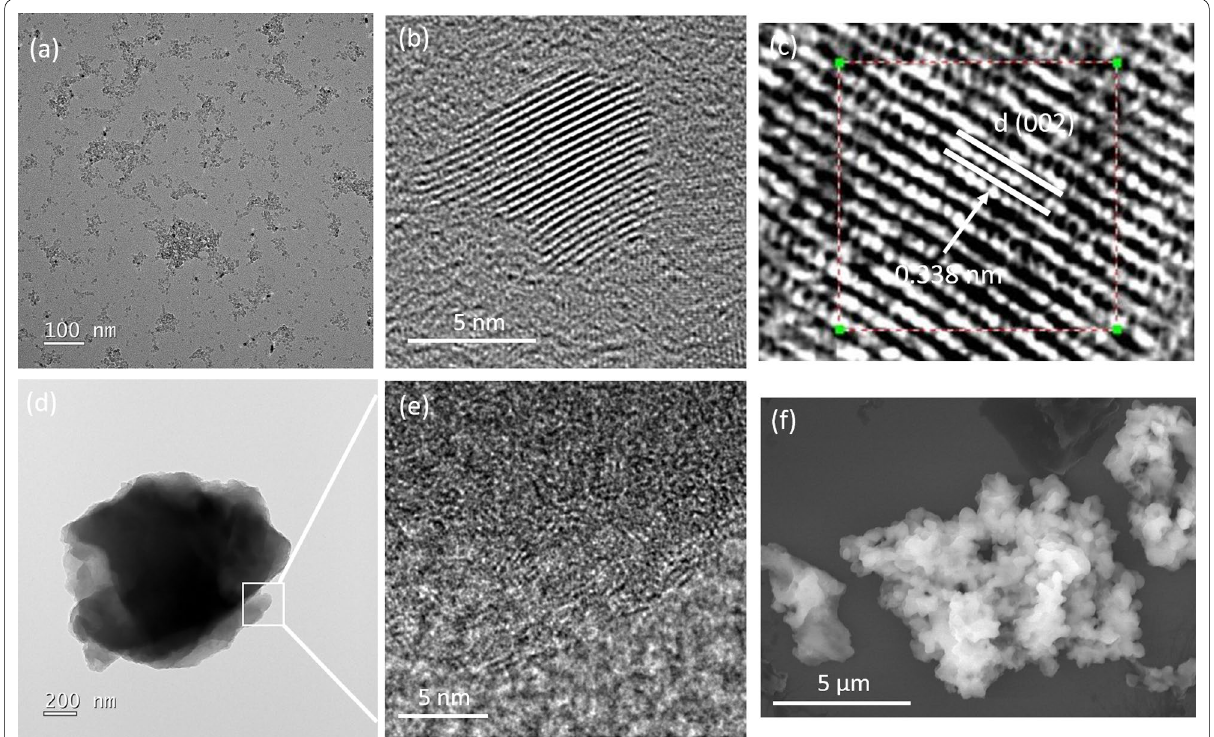
Fig. 1 Representative transmission electron micrograph (TEM) and scanning electron micrograph (SEM) of the as‑prepared BGH and BMH deposited from a dilute ethanol solution. a , b High and low magnification TEM of BGH, c high‑resolution TEM of BGH with distinct (002) lattice spacing of 0.338 nm, d TEM image of representative BMH at low magnification, e expanded TEM image of the boxed area in Fig. 1 d showing features of structural distortion within the layered graphene oxide, and f representative SEM image of